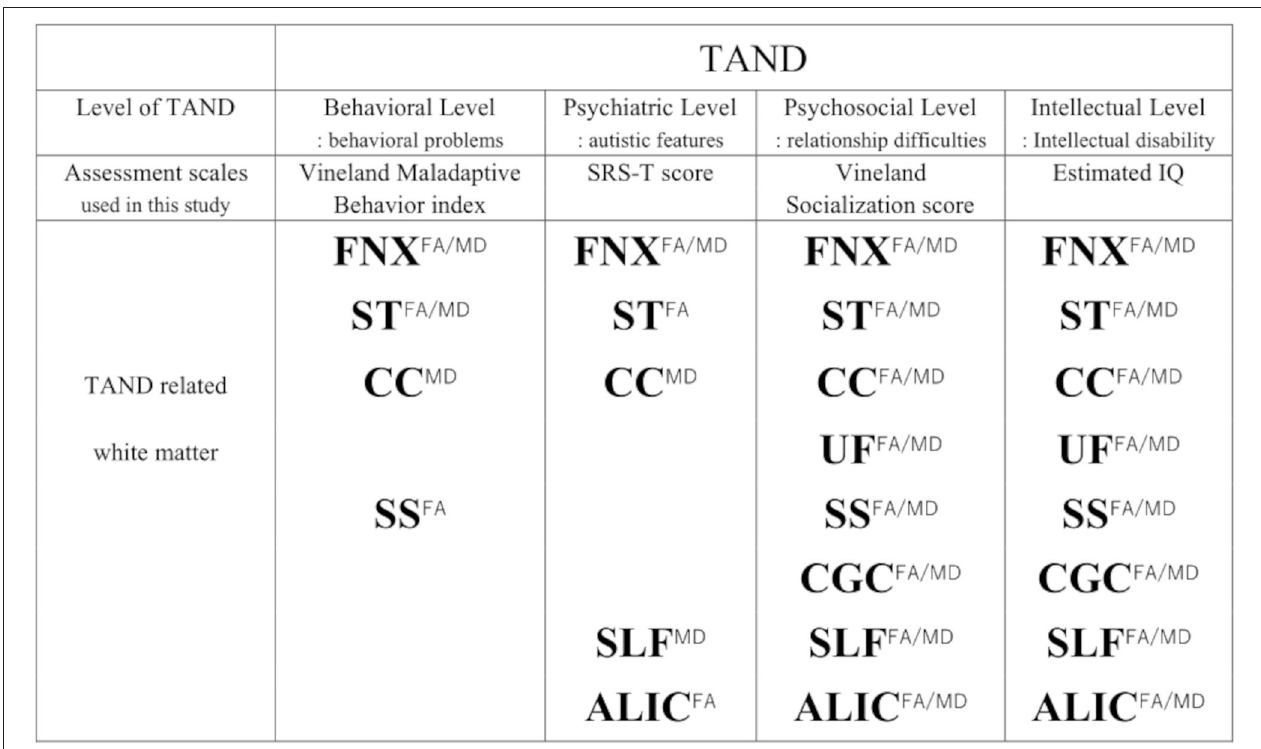
FIGURE 5 | Summary of TAND and related white matter depending on each TAND level. To assess TAND manifestations, Estimated IQ, Socialization score, Maladaptive Behavior Index, SRS-T score are used. Superscripts (FA/MD, FA, MD) means both FA and MD, FA, MD.FNX, body of the fornix; ST, stria terminalis; SS, sagittal stratum; CGC, cingulum in the cingulate gyrus; SLF, superior longitudinal fasciculus; UF, uncinate fasciculus; CC, splenium of the corpus callosum; ALIC, anterior limb of internal